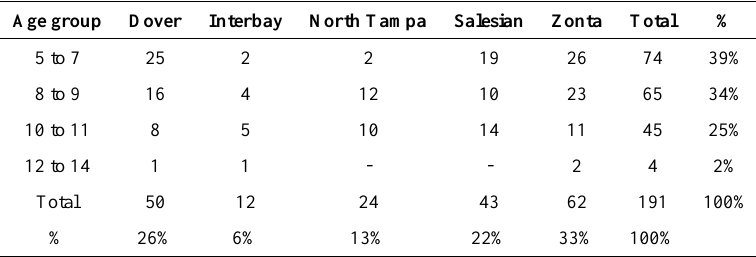
Table 1. The Children: Data Description by Age Group and